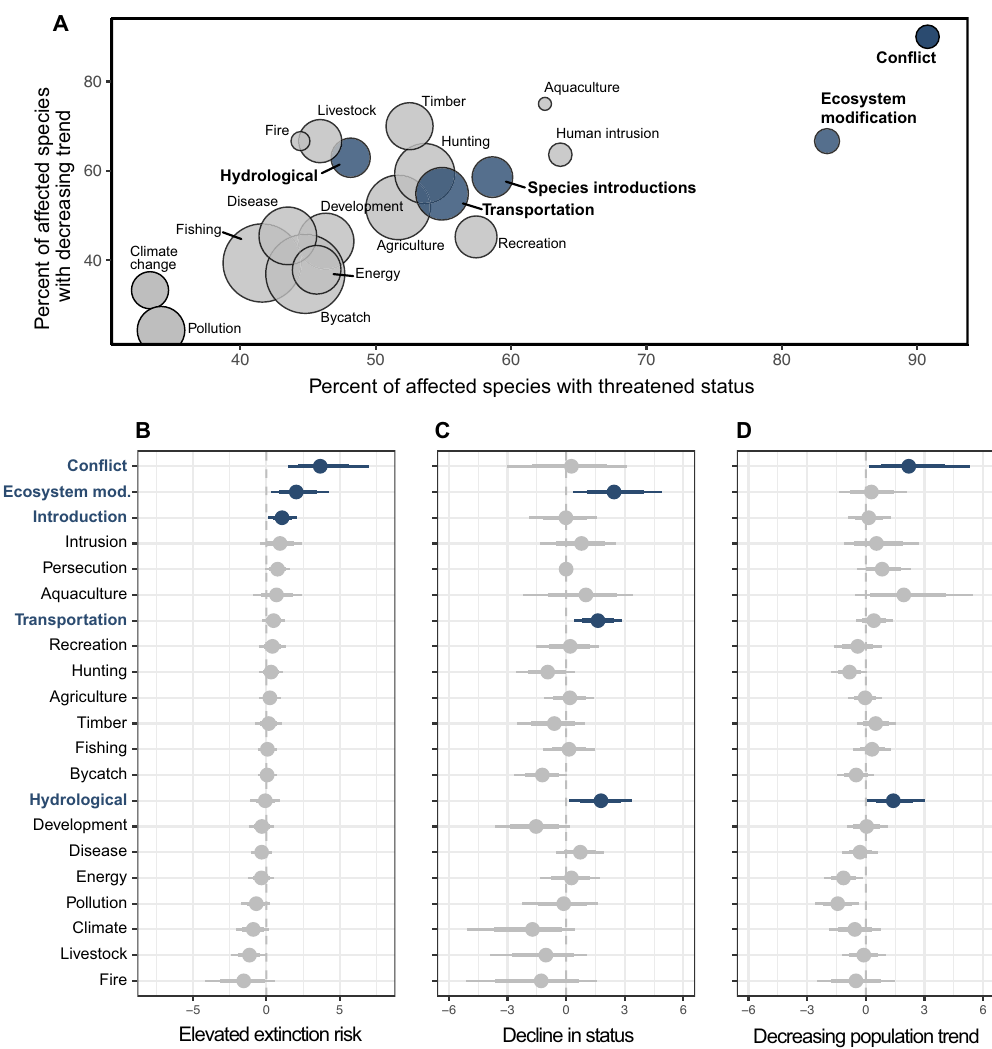
Figure 5. Ongoing declines and associations with anthropogenic sources of threat. ( A ) 23 anthropogenic threats (see descriptions in Table S6) plotted according to the percent of species affected by the threat with threatened status (x-axis) and with decreasing population trend (y-axis). The size of each point indicates the absolute number of species affected, ranging from fishing (n = 128) and bycatch (n = 125) to fire and aquaculture (n = 9 and 8, respectively). Points in blue are associated with at least one metric of decline. ( B ) The change in the log-odds of showing elevated extinction risk for species subject to each anthropogenic threat. Points to the right of the dashed vertical line (blue) indicate a significant positive association. Gray points indicate that confidence intervals overlap zero. Parameter estimates are coefficients of a binomial logistic regression model (with all other threats included), 95% confidence intervals (thin lines), and 90% confidence intervals (thick lines). ( C ) Associations between threats and decline in status (increasing extinction risk through time). ( D ) Associations between threats and a decreasing population